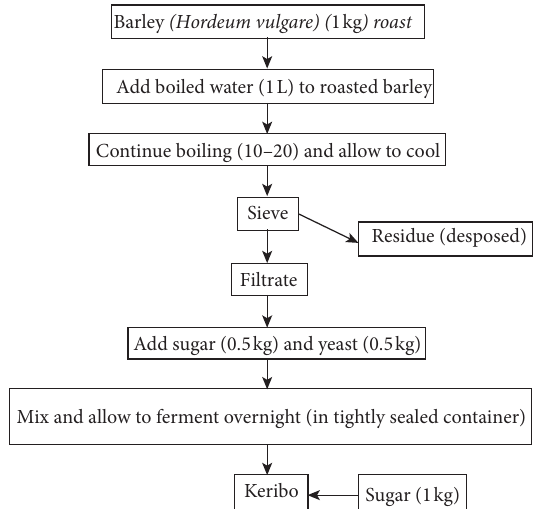
Figure 3: Flow chart of the traditional Keribo fermentation process